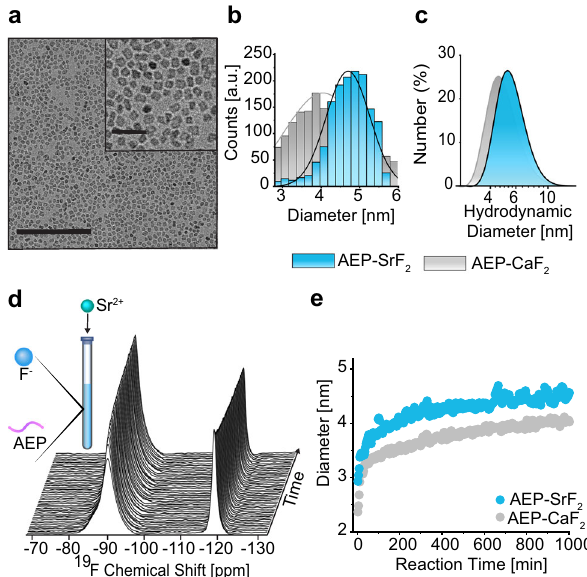
Fig. 3 AEP-SrF 2 NC formation. a Cryo-TEM of AEP-SrF 2 in water (1000 min after reaction initiation). b , c Size distributions of AEP-SrF 2 (light blue) and AEP-CaF 2 NCs (gray) as obtained from ( b ) cryo-TEM and ( c ) DLS. d Stack plot of the real-time 19 F-NMR spectra of AEP-SrF 2 synthesis. e Size evolution of the diameter of NCs in water throughout the reaction process for AEP-SrF 2 (light blue) and for AEP-CaF 2 (gray), as derived from Eq.